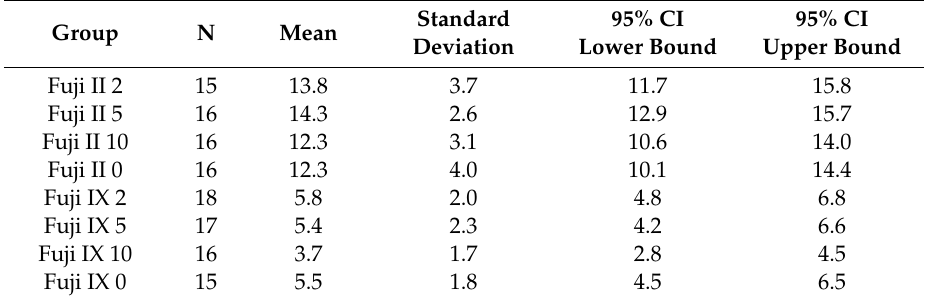
Table 2. Descriptive statistics for DTS in MPa (sample size, mean value, standard deviation, lower and upper bounds for 95% confidence interval).